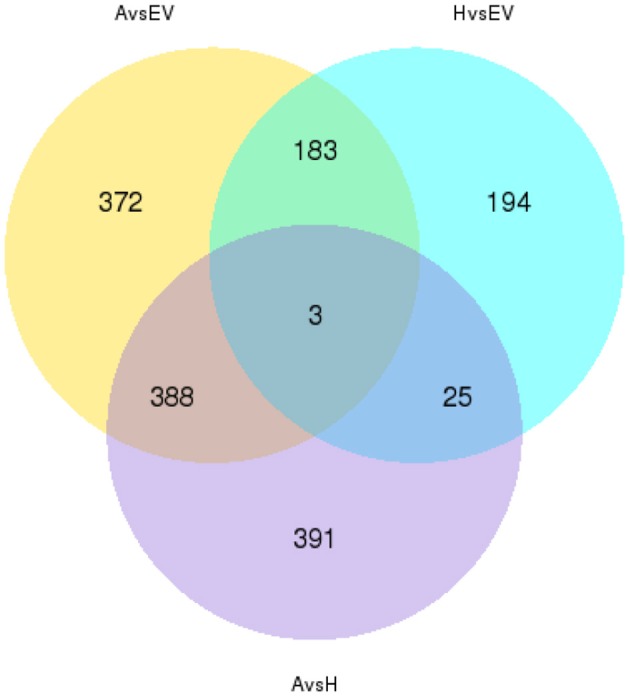
Venn diagram showing the number of differentially expressed genes between every two samples and the number of joint differentially expressed genes.